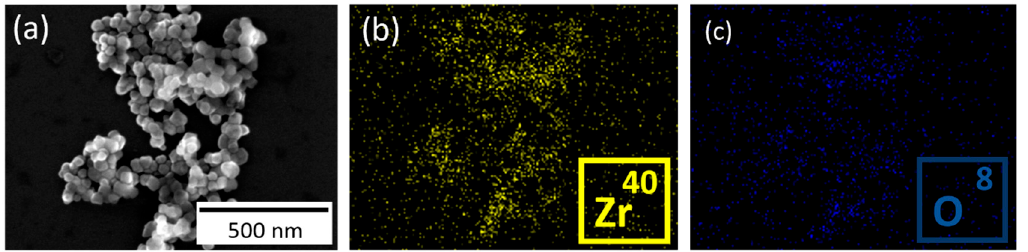
Figure 4. ( a ) SEM image of the ZrO 2 nanoparticles synthesized by microwave irradiation with a further calcination step at 800 °C for 15 min, together with the corresponding EDS maps of Zr ( b ) and O ( c ).